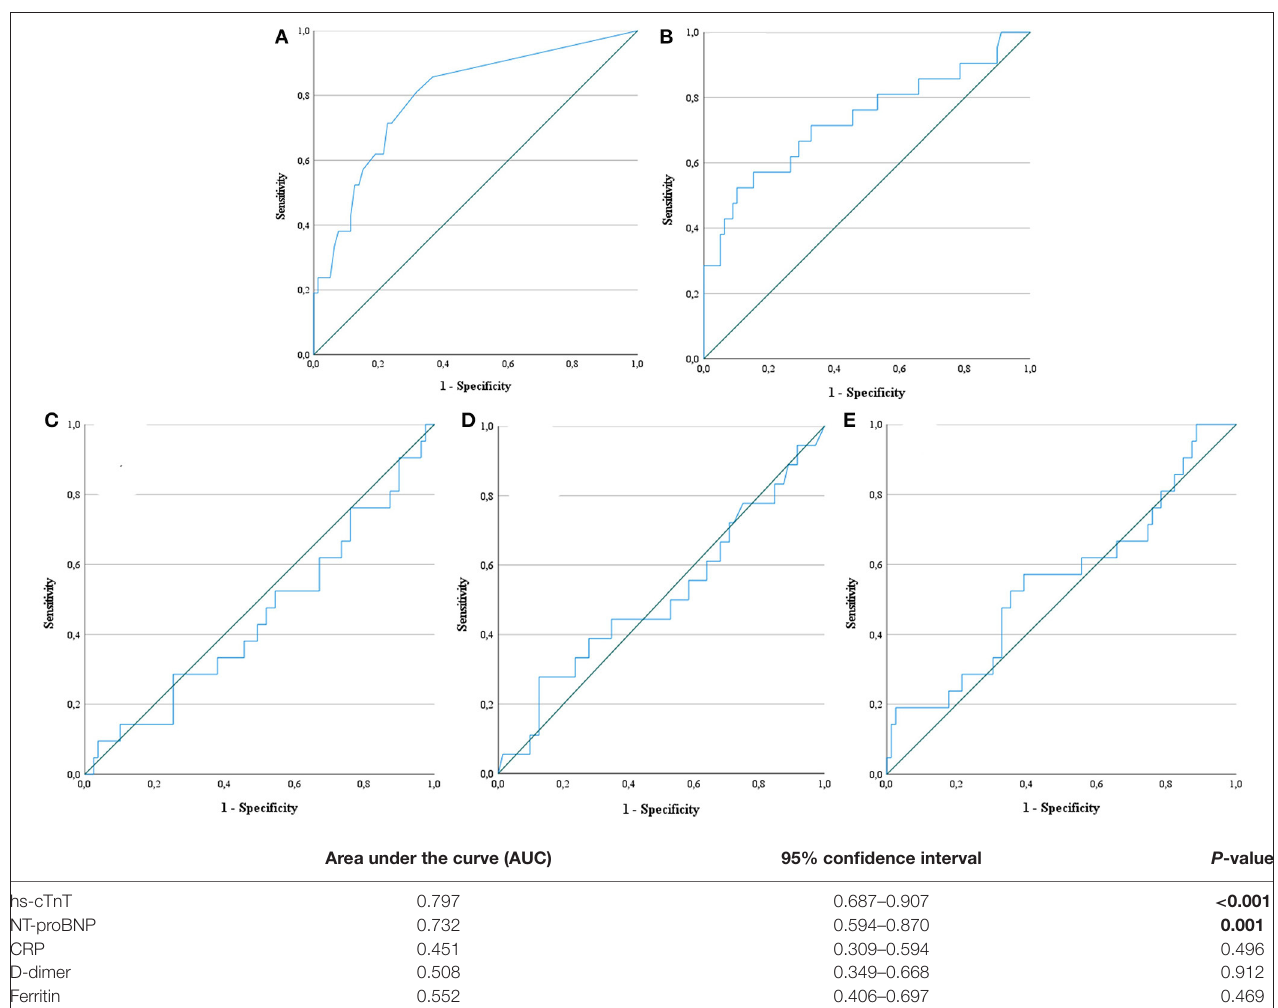
FIGURE 2 | Receiver operating characteristic curve. Receiver operating characteristic (ROC) curves for five biochemical markers: high-sensitive troponin T (A) , N-terminal pro-brain natriuretic peptide (B) , C-reactive protein (C) , D-dimer (D) and ferritin (E) . hs-cTnT, high-sensitive troponin T; NT-proBNP, N-terminal pro-brain natriuretic peptide. Statistically significant result are marked in